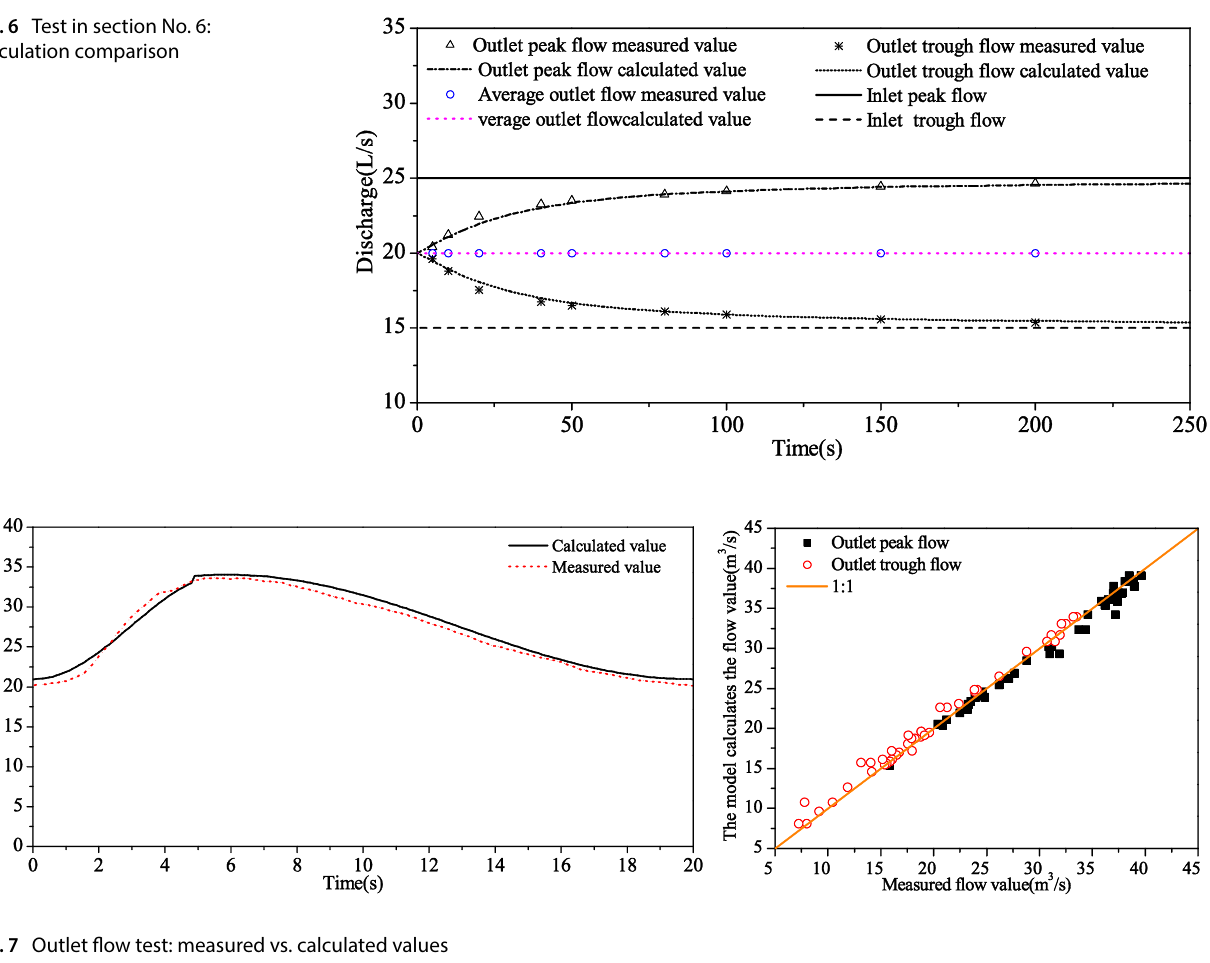
Fig. 7 Outlet flow test: measured vs. calculated